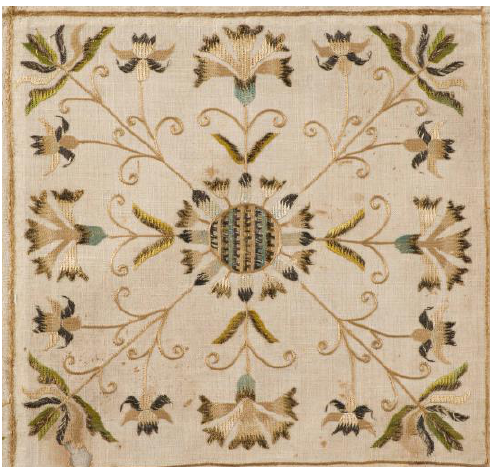
Figure 8. Fragment of a panelled cover cloth (late 17th century, Calvinist church of Marosvécs [Brâncovenești ], Transylvania, Romania). Cornflower is located in the centre of the motif from which carnations and tulips emerge. The central cornflower is a favourite stylistic element of Transylvanian embroideries (Museum of Applied Arts, Budapest. Photograph by Á ment Gellért. © Iparművészeti Múzeum).